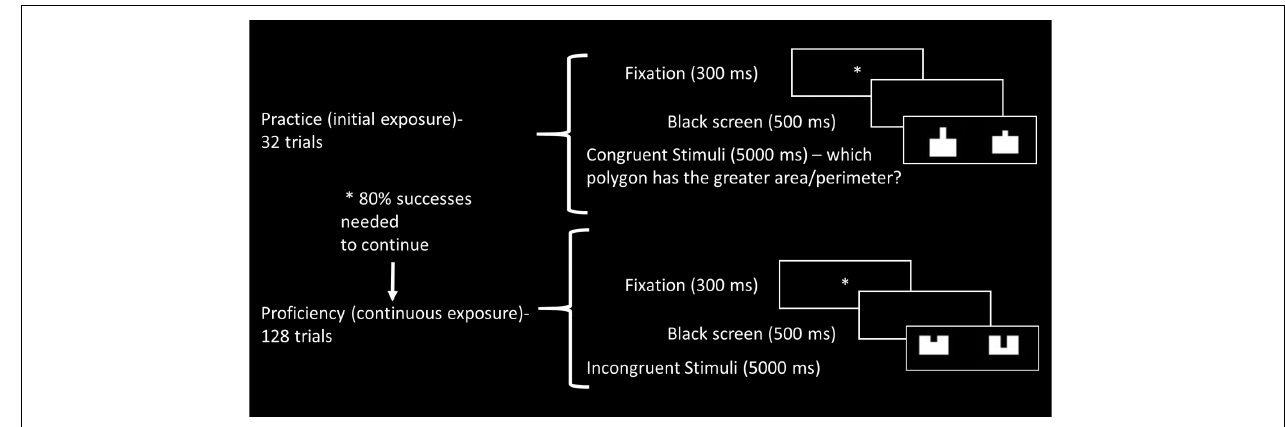
FIGURE 2 | Illustration of experimental block, including initial (practice) and continuous exposure (proficiency)